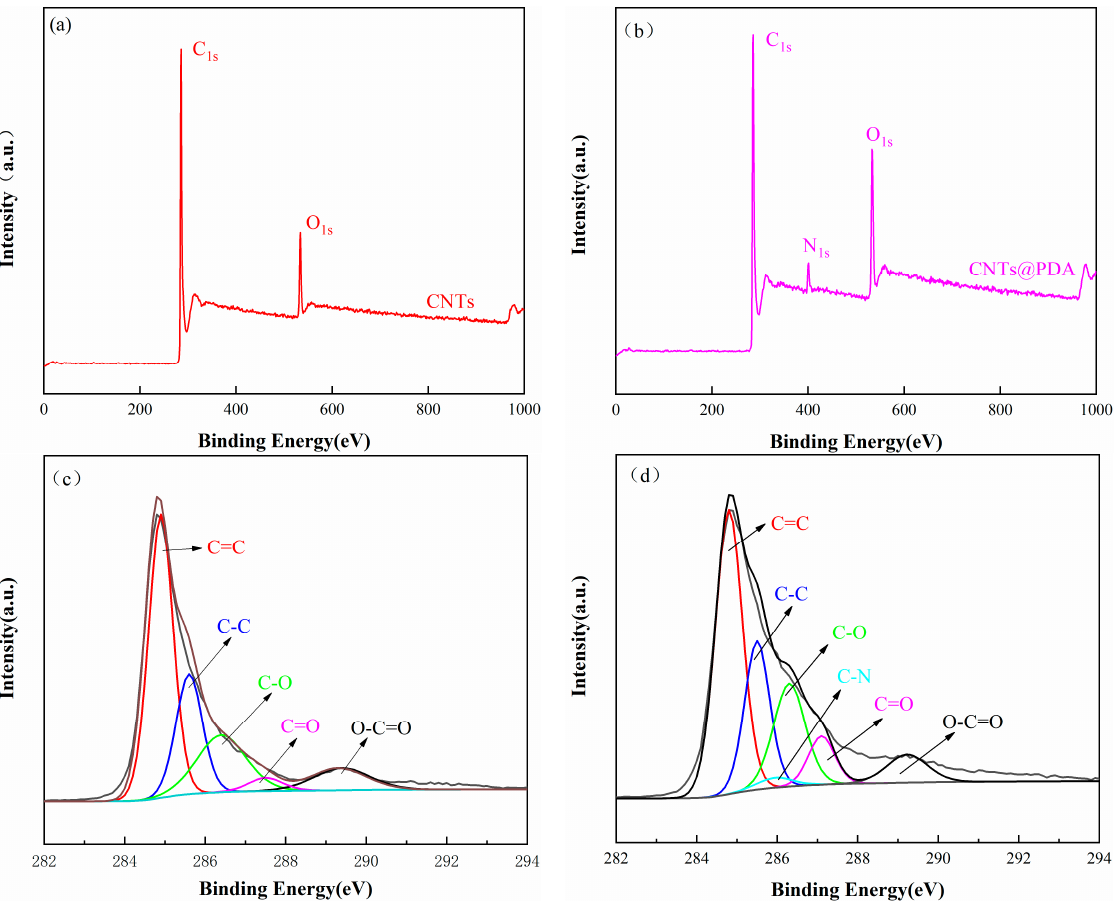
Figure 5. ( a ) XPS survey spectra of CNTs and ( b ) CNTs@PDA; C1s XPS spectra of ( c ) CNTs Table 1. Element content of CNTs and CNTs@PDA.